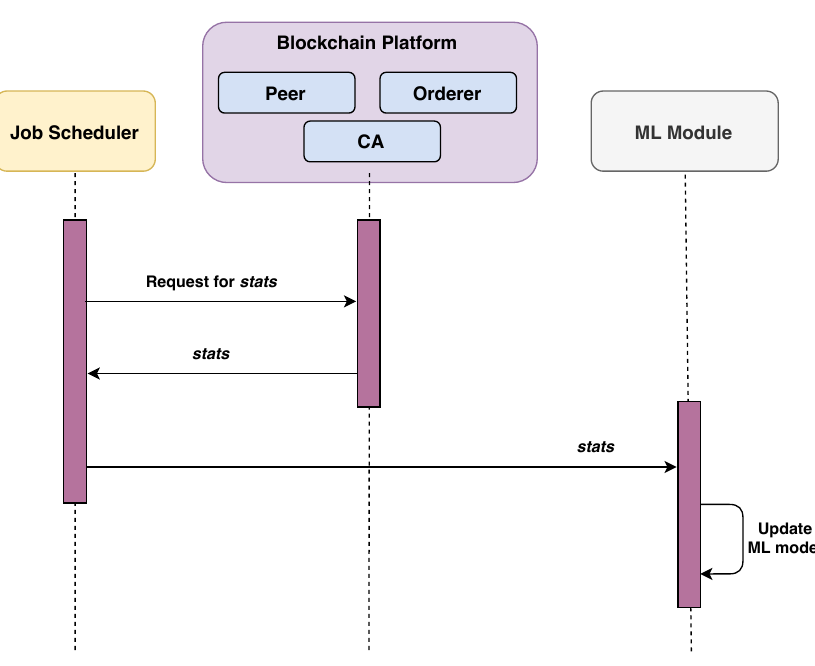
Figure 5. Blockchain network with ML